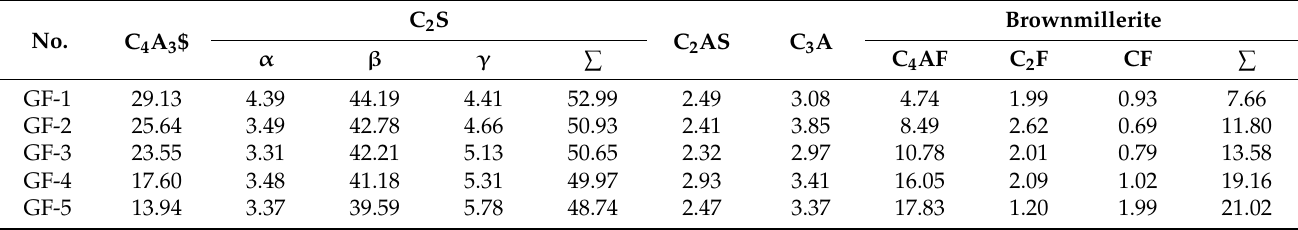
Table 9. Main mineral composition of HBSC clinker through QXRD patterns